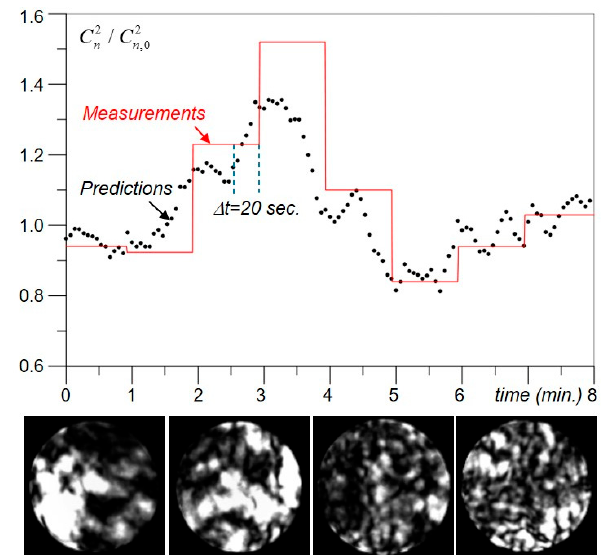
Figure 9. Eight minute segment of the C 2 n “measurement-vs.-prediction” plot in Figure 7c obtained with the Cn^2Net processing of the ATM #2-V data subset ( top ), and exemplary scintillation images captured during Δ t = 20 s time interval ( bottom ).